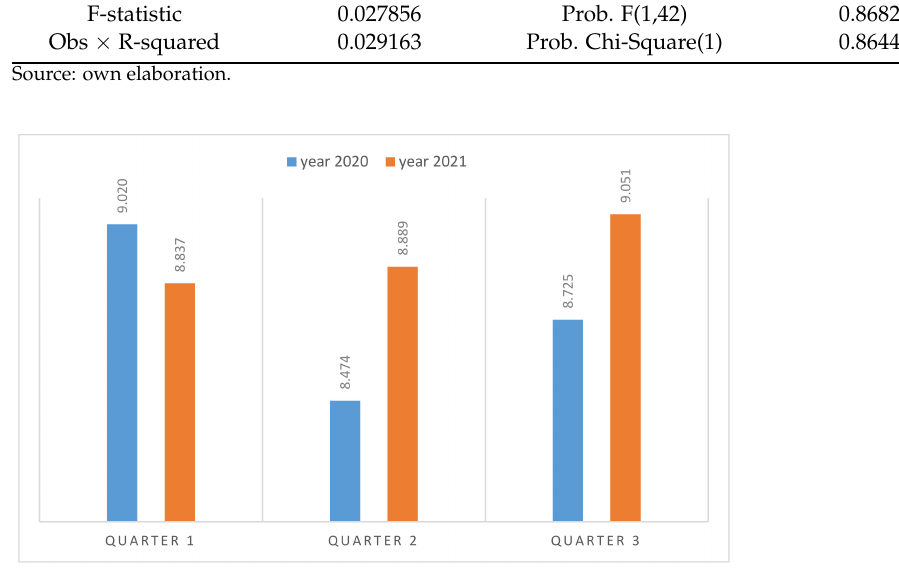
Table 9. ARCH test for heteroscedasticity. Heteroskedasticity Test: ARCH. Heteroskedasticity Test: ARCH